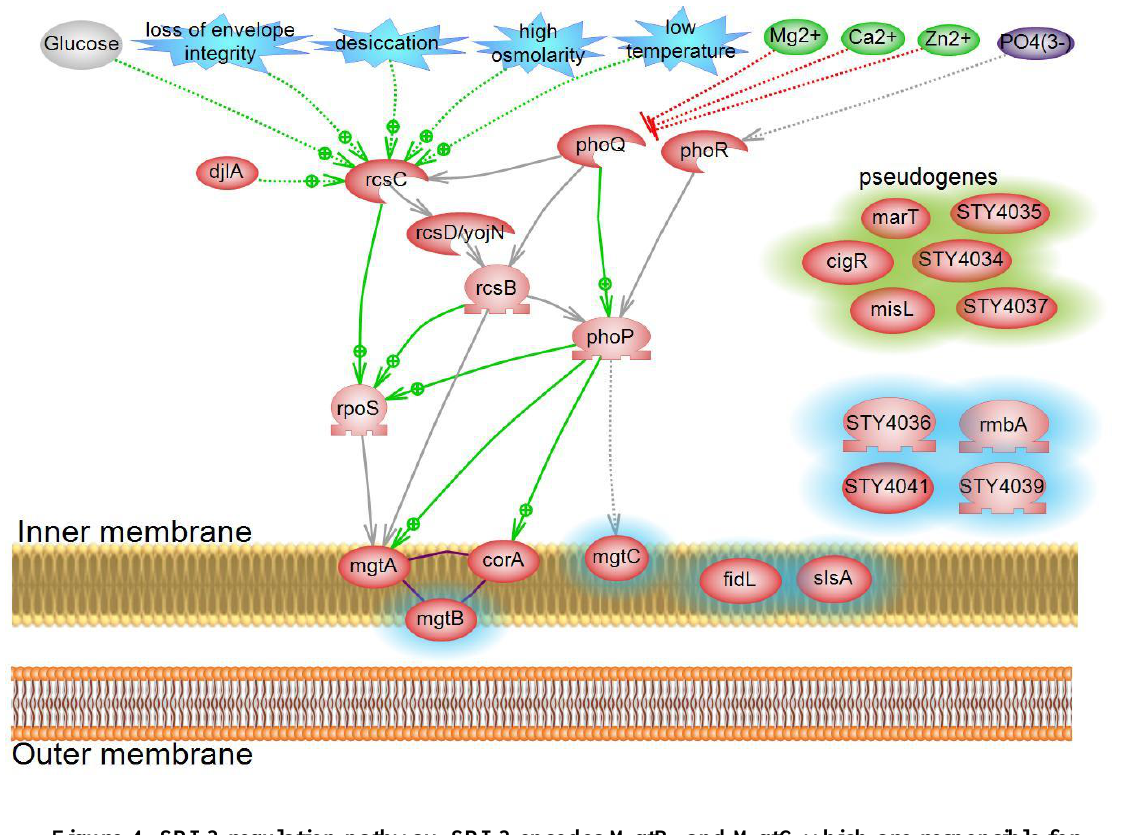
Figure 4: SPI-3 regulation pathway. SPI-3 encodes MgtB, and MgtC which are responsible for Mg 2 + uptake. Most SPI-3 proteins remain unconnected. Proteins encoded by SPI-3 are highlighted in blue. A detailed view of the SPI-3 pathway including supporting literature is available at